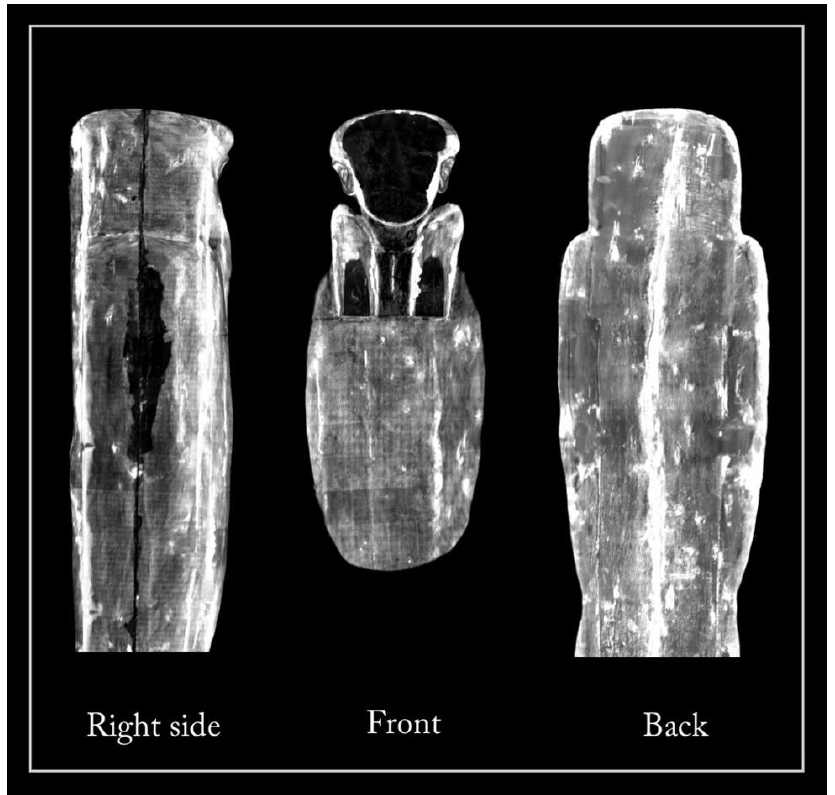
Figure 16. The incamottatura on the outer surface of the coffin.